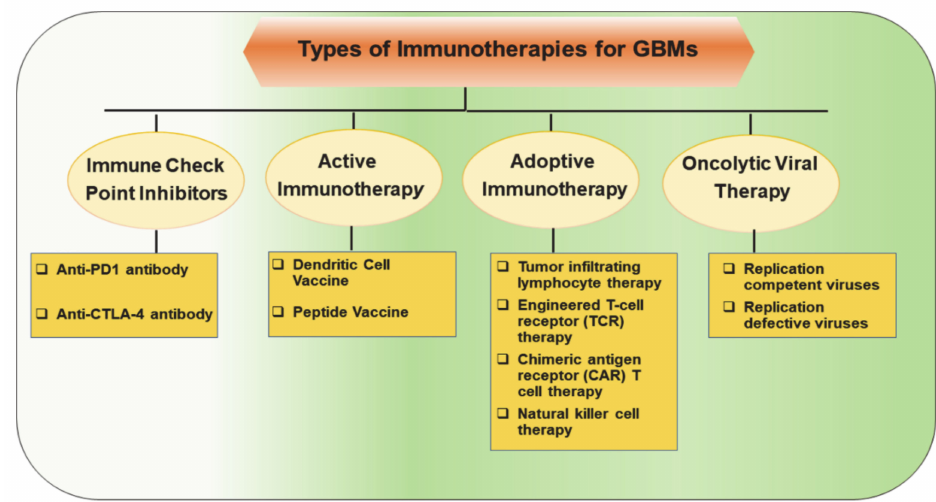
Figure 1. Major classes of immunotherapeutic approaches to harness patient’s immune response against tumor cells in glioblastomas